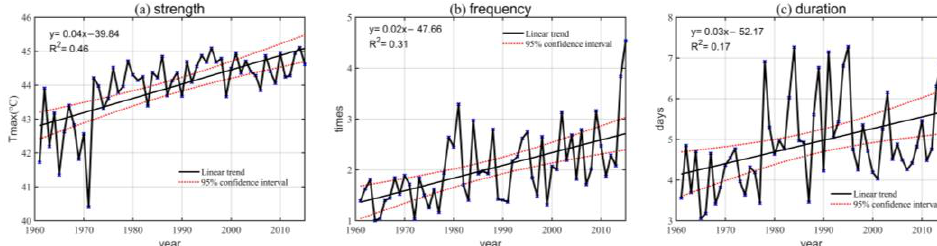
Figure 5. Time variation of extreme high-temperature events over the CPEC during 1961 – 2015: ( a ) strength; ( b ) frequency; ( c ) intensity (the straight line is a linear trend, and the red dotted line is a 95% confidence interval).